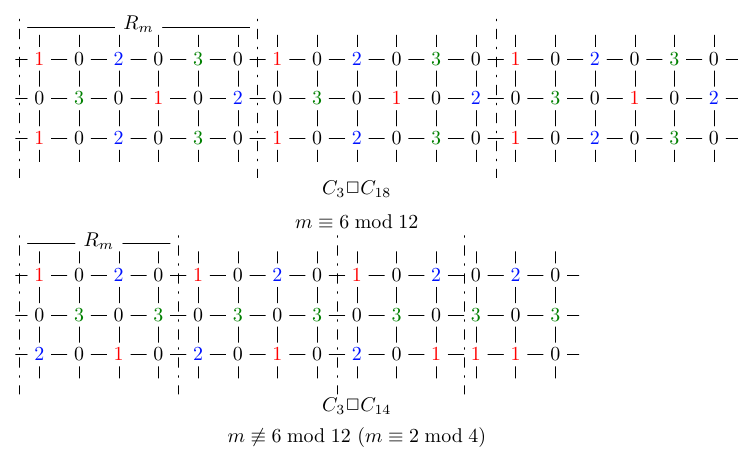
Figure 8. 3RDFs on C 3 2 C 18 and C 3 2 C 14 Figure 8. 3RDFs on C 3 (cid:50) C 18 and C 3 (cid:50) C 14